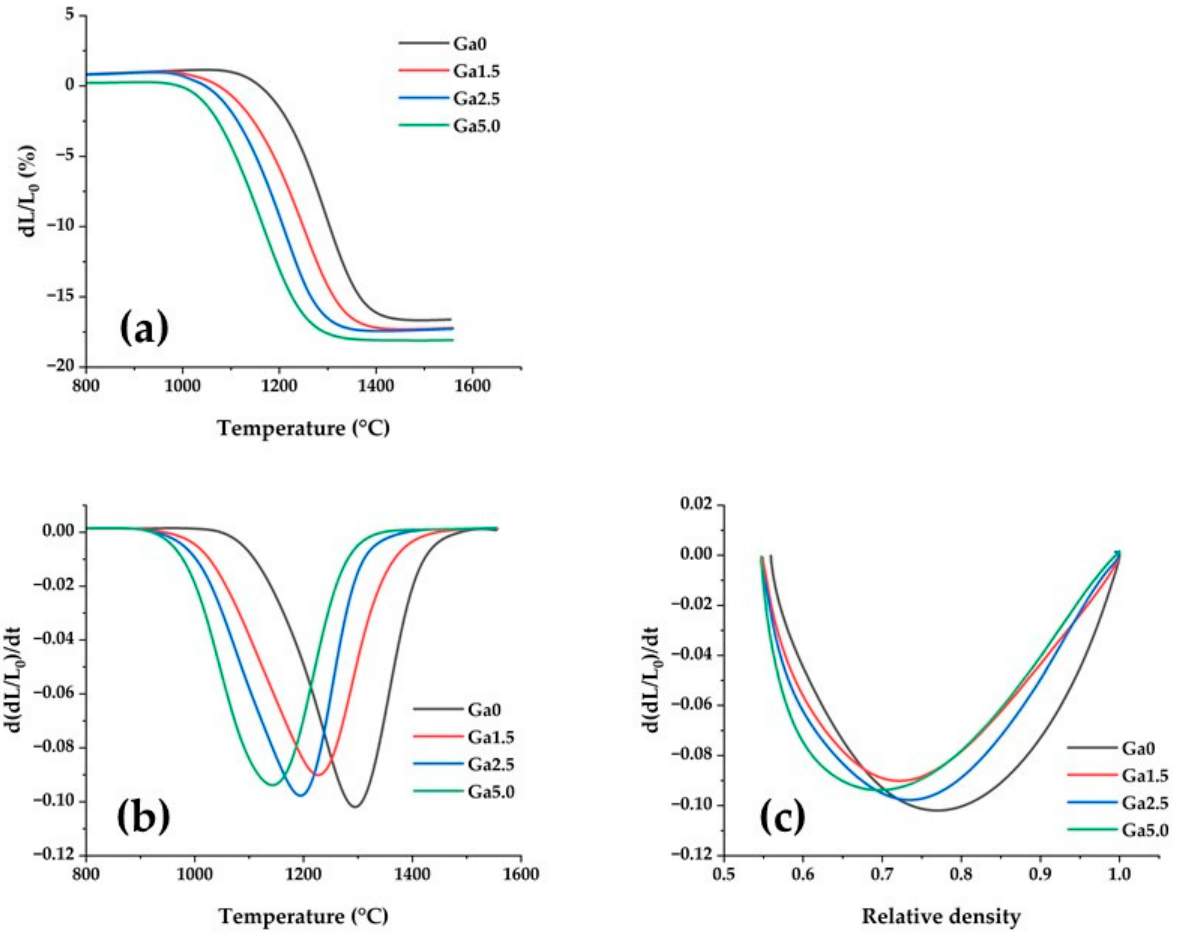
Figure 3. Relationship between: ( a ) shrinkage rate and temperature, ( b ) first derivative of shrinkage rate and temperature, ( c ) first derivative of shrinkage rate and relative density.